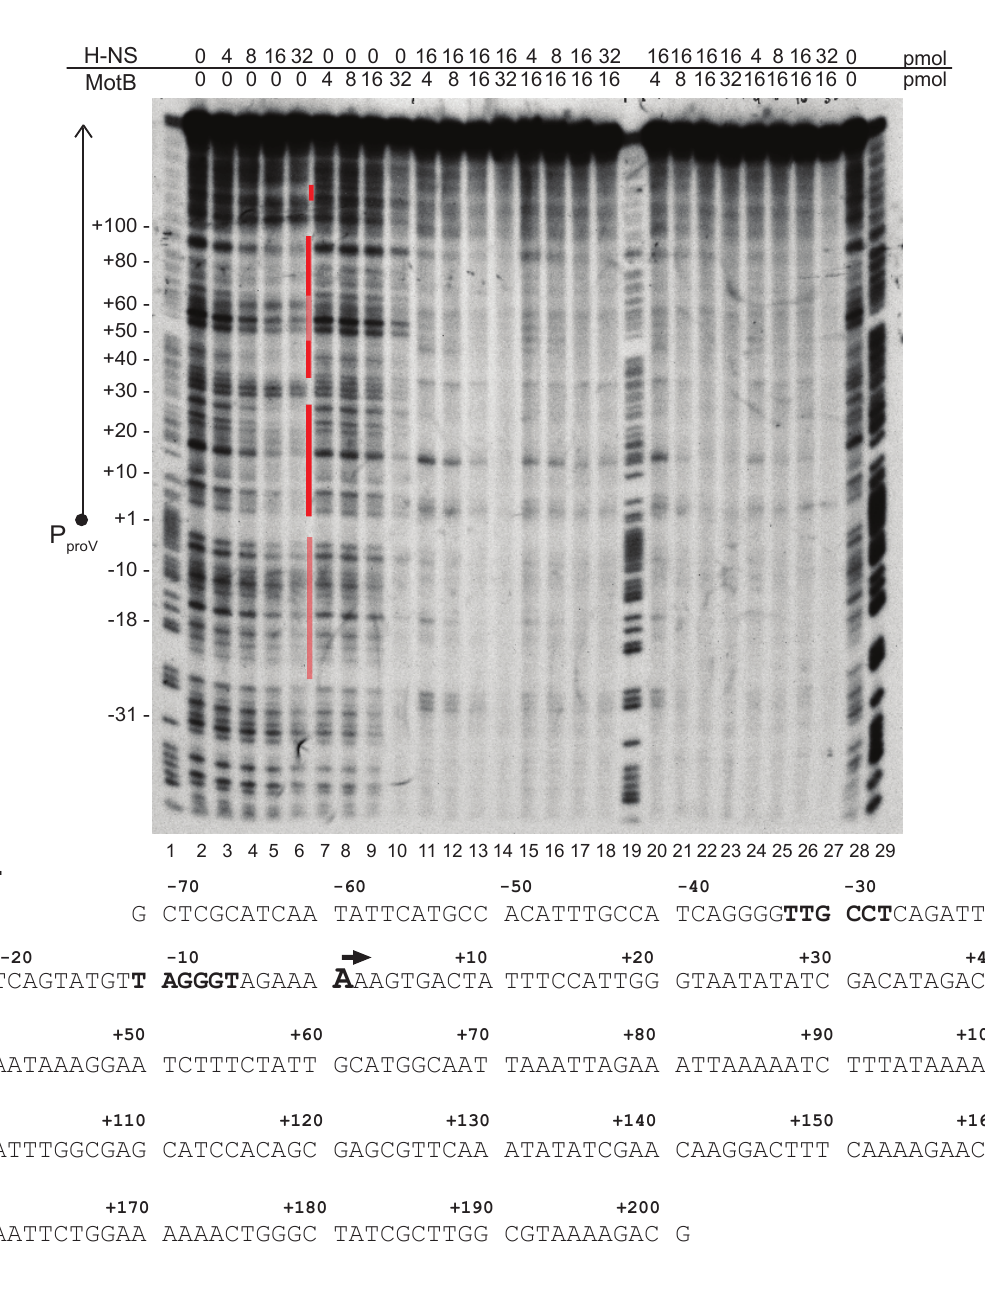
Figure 3. Representative DNase I footprint of MotB and/or H-NS at P proV and the P proV sequence. ( A ) DNA surrounding the P proV promoter (positions − 71 to +201; 0.05 pmol DNA; 13.6 pmol total bp; 5’- 32 P labeled on the nontemplate strand) was incubated with the indicated amount of MotB-His and/or H-NS and treated with DNase I before electrophoresis on a 5% (w/v) polyacrylamide, 7 M urea denaturing gel. A schematic of the P proV promoter region is shown to the left of the gel, and the positions corresponding to the DNA sequence determined from the G + A ladder are indicated. Regions protected or partially protected by H-NS are indicated by the dark and light red bars, respectively, to the right of lane 6. Lanes 1, 19, 29: G + A ladder; lane 2, 28: no protein control; lanes 3–6: 4 pmol, 8 pmol, 16 pmol, and 32 pmol H-NS, respectively;